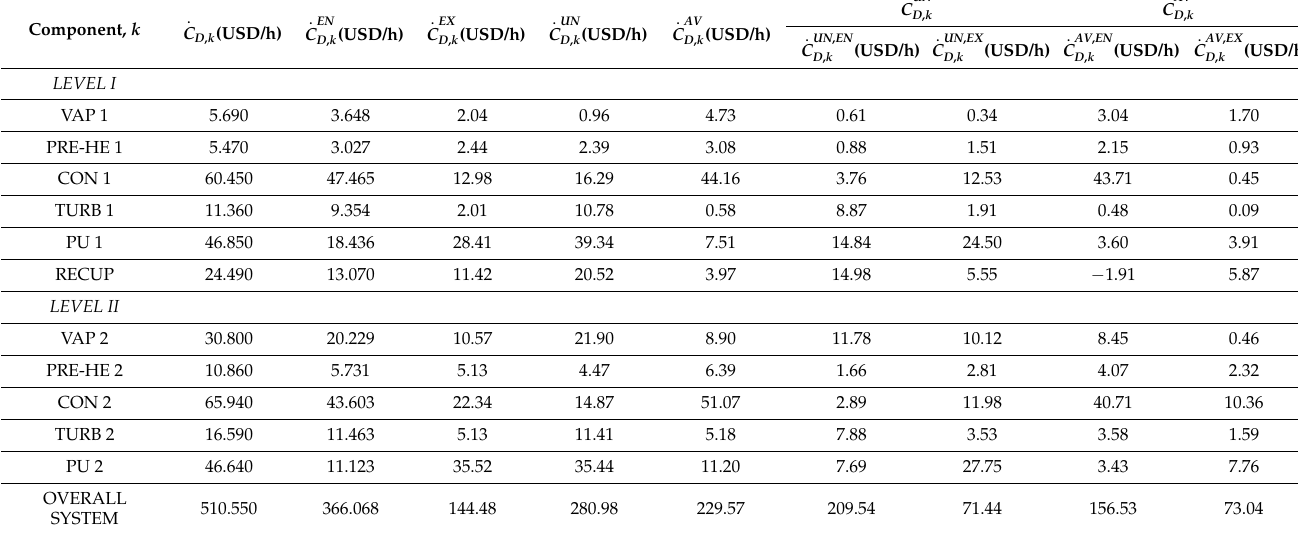
Table 6. The findings of the AdvExEcon analysis for the exergy destruction cost rates of all the